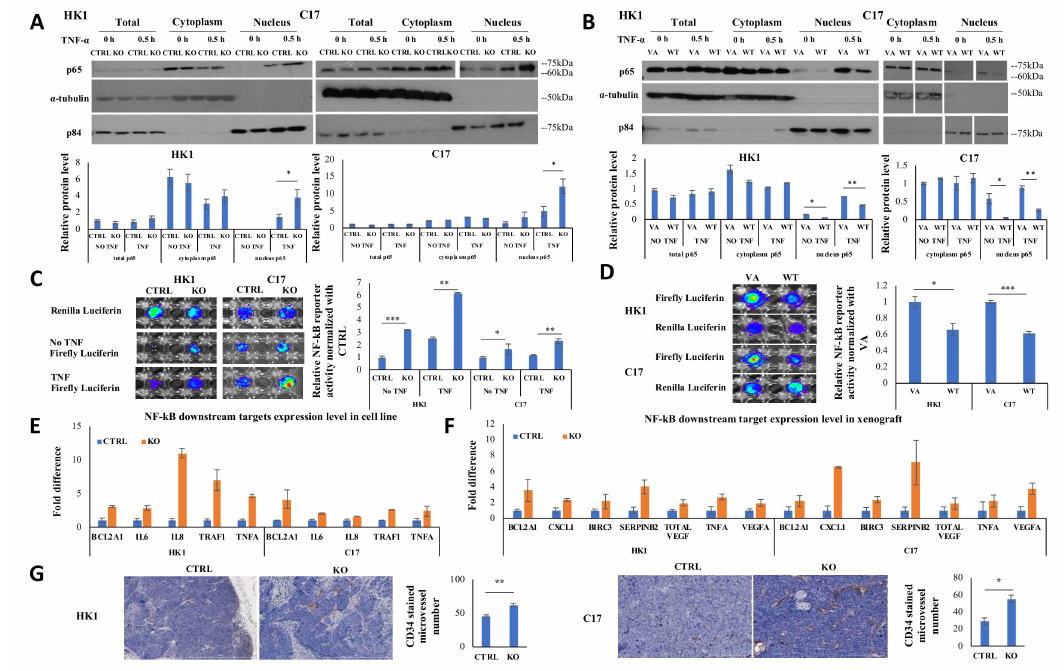
Figure 4. CYLD acts as a negative regulator of the NF-kB pathway in NPC. ( A ) HK1 and C17 with CYLD knockout / control were treated with 30 ng / mL TNF- α for 0.5 hour prior to subcellular fractionation and Western blot analysis to detect p65 nucleus translocation. The quantification by densitometry is shown in the bar graphs. Without TNF- α stimulation, most p65 localizes to the cytoplasm. After 0.5 hour of stimulation, more p65 was translocated into the nucleus in both HK1 and C17 with CYLD knockout compared to control. The p84 and α -tubulin were used as loading controls. ( B ) HK1 and C17 overexpressing CYLD / VA were treated with 30 ng / mL TNF- α for 0.5 hour and then subjected to subcellular fractionation and Western blot with quantification by densitometry shown in the bar graphs. Consistently, less p65 was translocated into nucleus in the cells with CYLD overexpression compared to the VA. ( C , D ) the NF-kB-specific reporter assay was used to examine the NF-kB signals in HK1 and C17. Renilla luciferase serves as a normalization control. Firefly luciferase indicates NF-kB reporter signal. Quantification of the bioluminescent signal is shown in the bar graph. ( E ) NF-kB downstream targets were screened by qRT-PCR in both HK1 and C17 cells with CYLD knockout / control. Several genes with over two-fold di ff erences in both HK1 and C17 are shown. ( F ) NF-kB downstream targets were screened by qRT-PCR in both HK1 and C17 xenografts with CYLD knockout / control. More NF-kB downstream targets were upregulated. ( G ) IHC staining of the HK1 and C17 xenografts shows more microvessel formation (Cd34-positive) after CYLD knockout, as compared to control. ImageJ was used to count microvessel numbers. Scale bar = 1000 µ m. The data shown are represented as mean ± standard deviation (SD); n = 3. CTRL: nontarget control; KO: CYLD -targeted knockout; VA: overexpression vector-alone; WT: overexpression CYLD wild-type. *: p -Value < 0.05; **: p -Value <